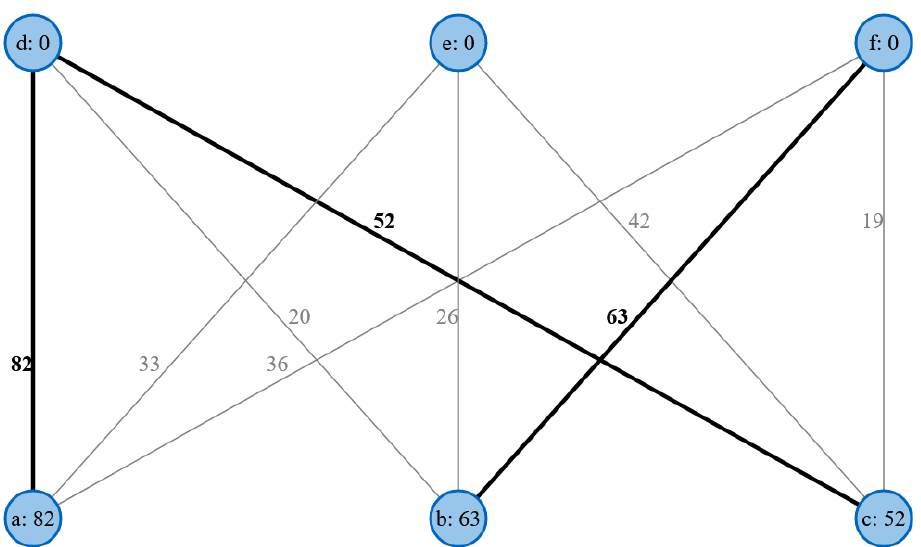
Figure 1. Bipartite Graph.